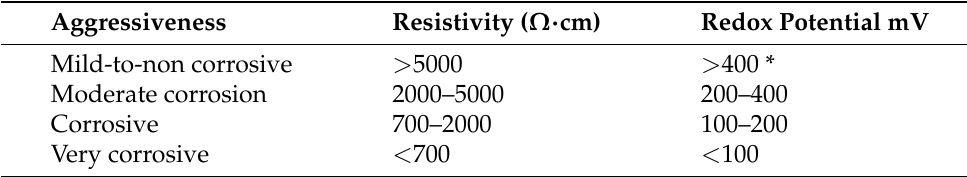
Table 1. Soil aggressiveness based on the resistivity and redox potential